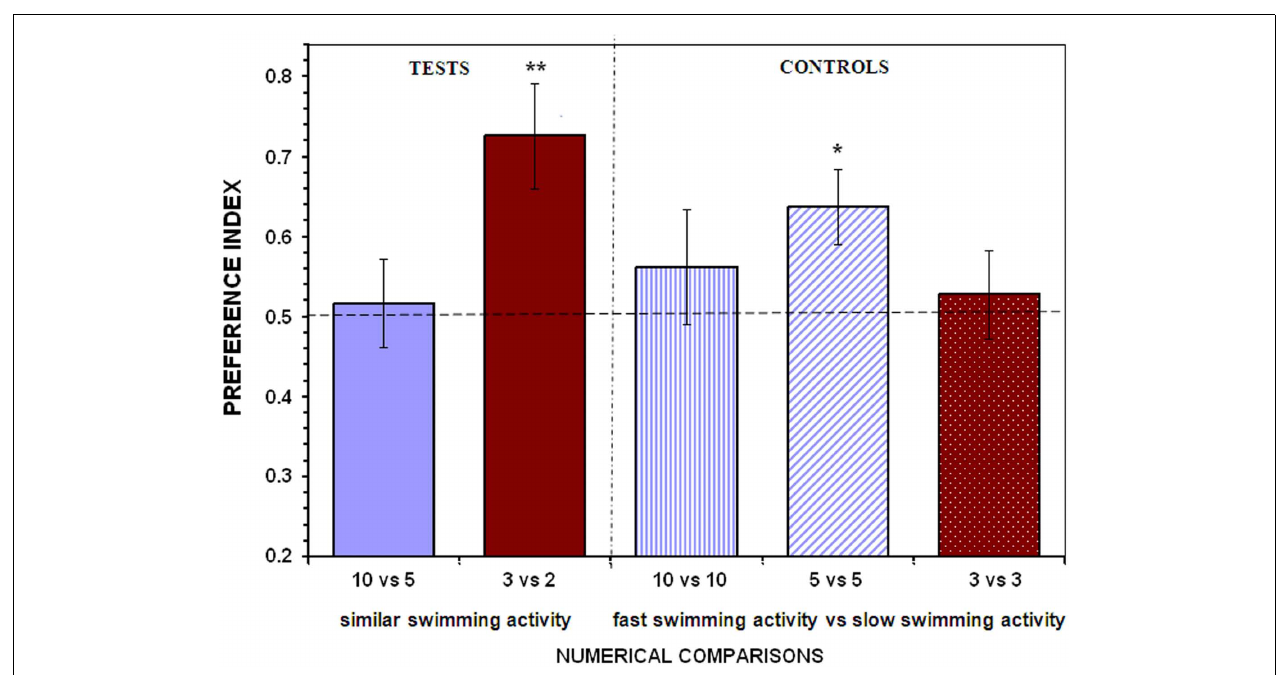
other at 21˚C. Proportion of time ( preference index ) spent by test fish in the 10cm preference zone close to stimulus fish (mean ± SEM) is shown. Values above 0.5 indicate a preference for the more numerous shoal of stimulus fish or a preference for the more active, faster moving shoal when the stimulus shoals are of the same numerical size. Significant departure from the null hypothesis of no preference is indicated by asterisks: ** P < 0.01, * P <